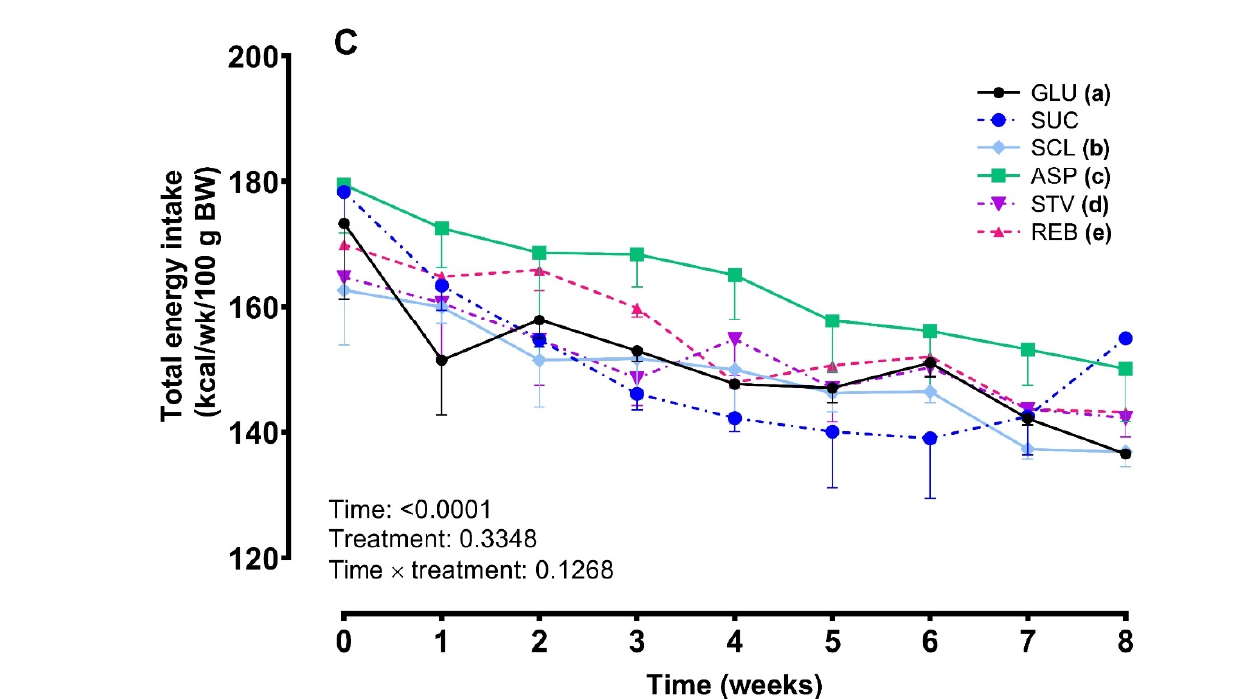
Figure 3. Effects of NNS on food intake ( A ), fluid intake ( B ) and total energy intake ( C ) in the ND-treated group throughout 8 weeks of treatment (phase 2). Data are expressed as mean ± SEM. ( n = 6–8 animals per group). Two-way RM ANOVA followed by Tukey’s post hoc test was used. Different lowercase letters in each time point indicate significant differences between the sucrose group (SUC) and other groups: (a) GLU, glucose; (b) SCL, sucralose; (c) ASP, aspartame; (d) STV, stevia; (e) REB, reb A ( p < 0.05).